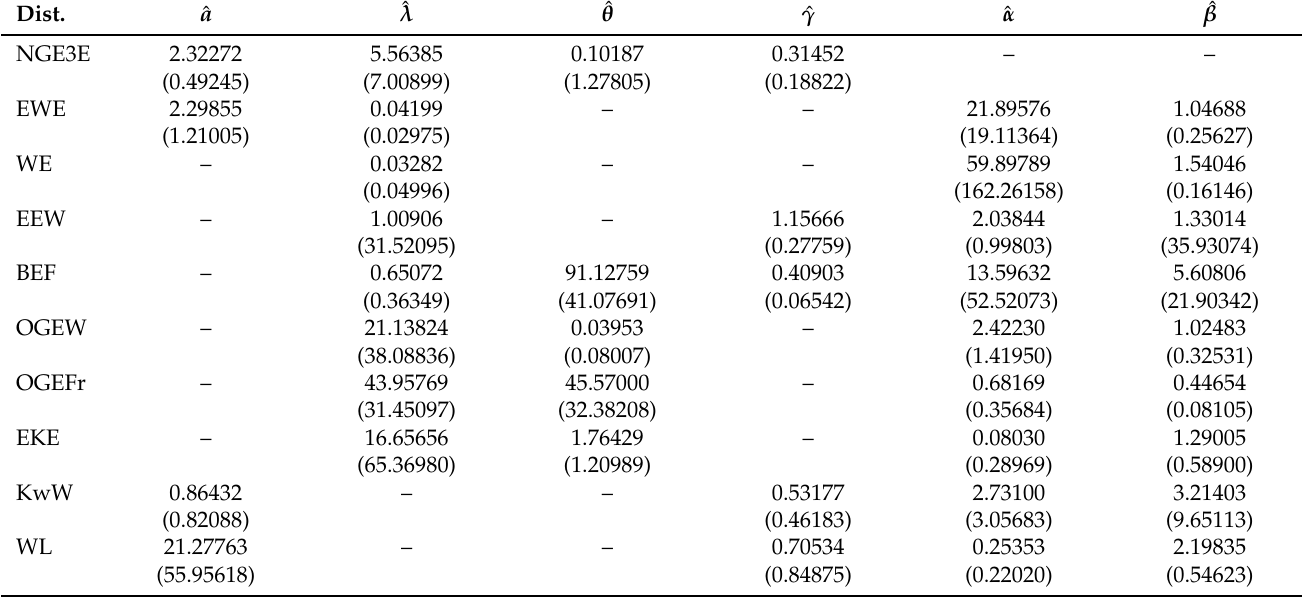
Table 3. MLEs with SE (in parentheses) of CMs for guinea-pig data.